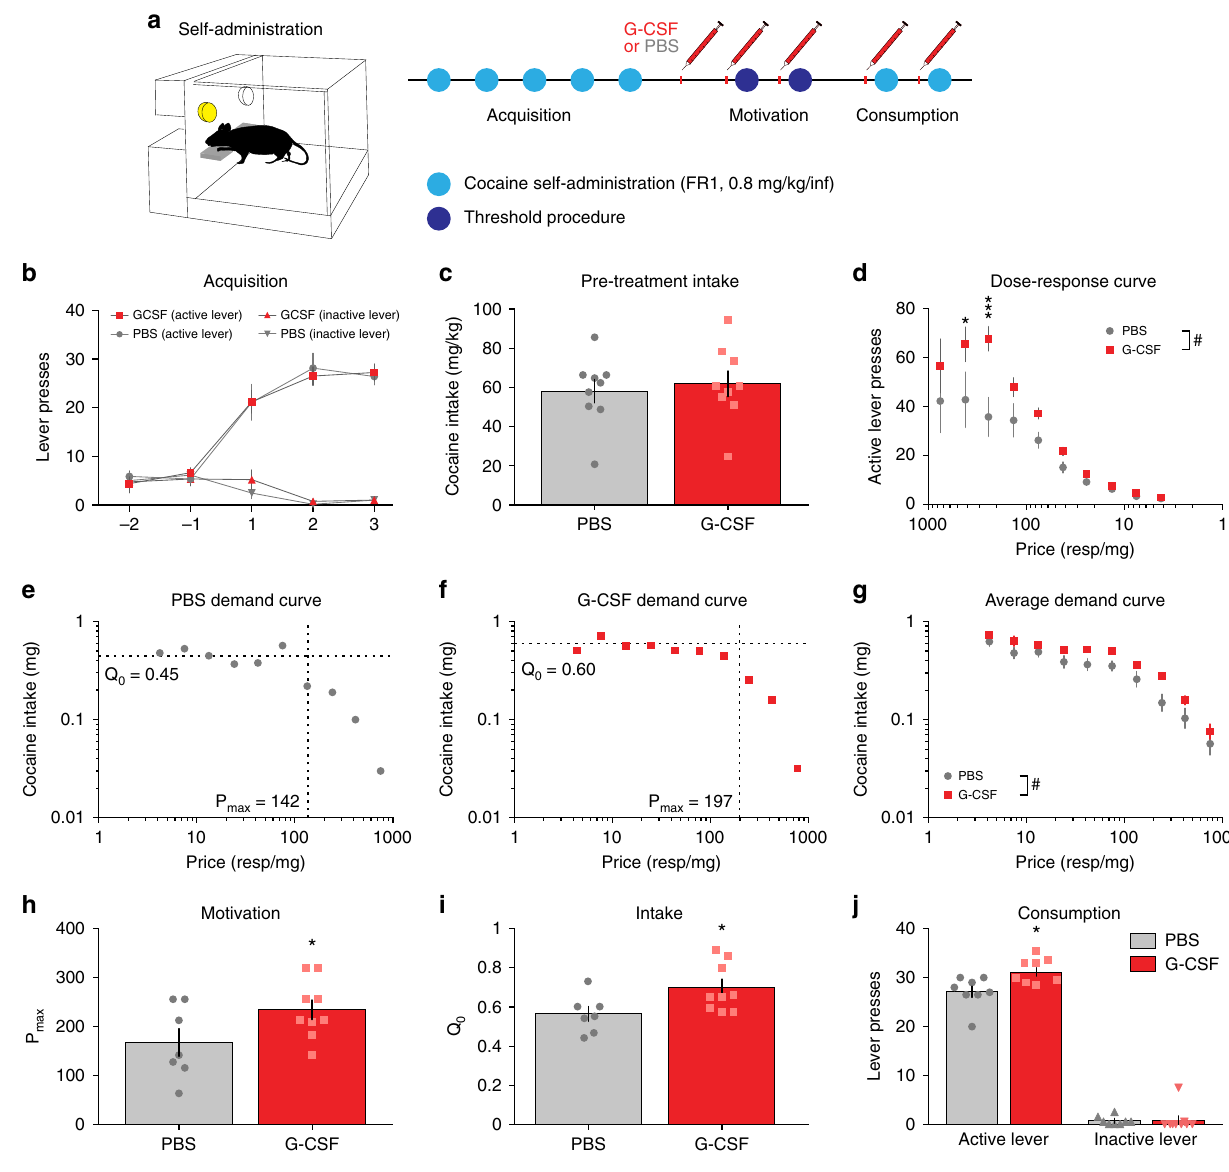
Fig. 8 G-CSF increases the motivation to self-administer cocaine. a Experimental timeline. Rats were trained to self-administer cocaine on a fi xed-ratio one (FR1) schedule of reinforcement. Animals went through two behavioral tasks: the threshold procedure to assess motivation, and FR1 self-administration to assess consumption. b Acquisition for the two experimental groups before treatment showing that there were no signi fi cant differences before